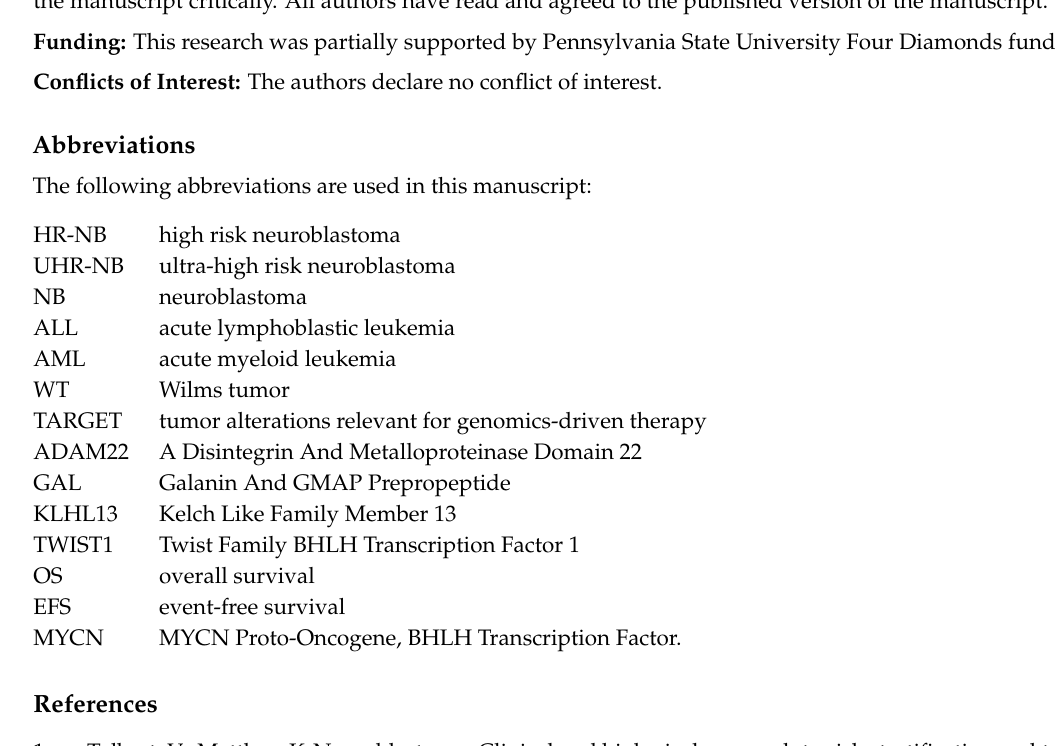
Figure S1: Detailed Kaplan-Meier survival curves for both TARGET and GSE49710. The overall survival (OS) of ultra-high risk neuroblastoma (UHR-NB) vs high risk neuroblastoma (HR-NB). A, OS in TARGET. B, the OS for GSE49710, Table S1: The average expression of 283 NB-specific immune-related genes in 4 pediatric tumors. The gene expression was normalized with log2 transformation and quantile normalization, Table S2: Three Subtypes in TARGET and GSE49710 cohorts. The subtypes were discovered with spectral co-clustering algorithm, Table S3: Differentiated NB-specific immune-related genes in both cohorts, when comparing UHR-NB with HR-NB. The genes were selected from 283 NB-specific immune-related genes with more than 1.5 fold changes and the p value of less than 1.0 × 10 − 3 , Table S4: Overall survival for 39 NB-specific differential genes with Cox regression in two cohorts, where Beta is the estimated coefficient for each gene with univariate and multivariate Cox regression, Hazard Ratio denotes the marginal hazard ratio for each gene, HR_LB is the 95% lower bound of hazard ratio, and HR_UB is the 95% upper bound of the hazard ratio, Table S5: Differentiated immune-related genes in both cohorts, when comparing UHR-NB vs HR-NB. The genes were selected with the 4723 immune-related genes from InnateDB (https://www.innatedb.com/). More than 1.5 fold and p < 1.0 × 10 − 3 were used as a cutoff for gene selection, Table S6: KEGG pathways for 311 downregulated immune-related genes in UHR-NB subtype. 43 KEGG pathways with molecular/metabolic/signialing functions were enriched in HR-NB with FDR <